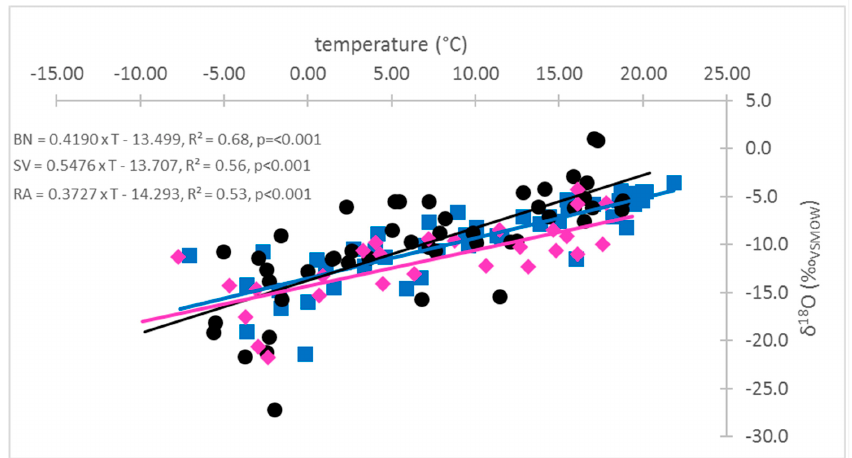
Figure 5. Monthly variation of mean temperature (red) from the gridded E-OBS (daily gridded observational dataset) of the nearest point of the stations and δ 18 O in precipitation at BN (blue), SV (black) and RA (yellow).